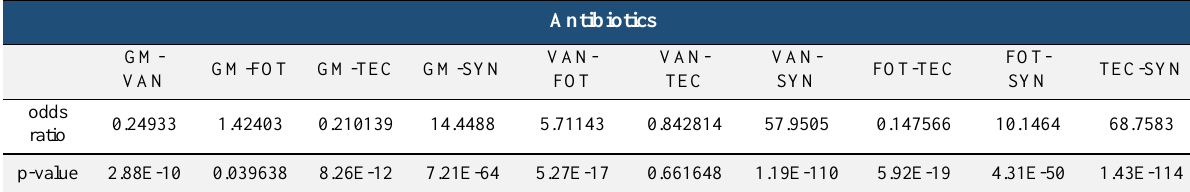
Table 2. Correlation between resistance to selected antibiotics in isolated samples. There are significant differences between the numbers of resistant samples to one antibiotic versus the other. The rows are Fisher’s exact test’s odds ratio and its p-value, corrected for multiple testing by using FDR. The columns are comparisons between pairs of antibiotics. Antibiotics